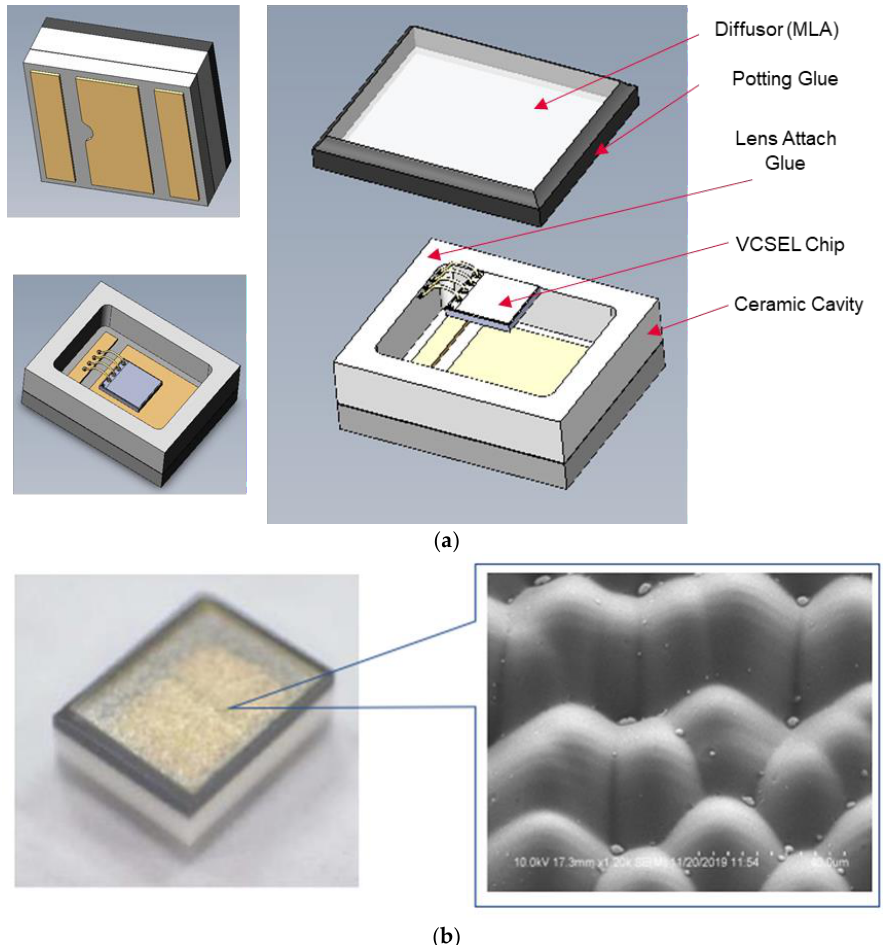
Figure 1. The VCSEL package. ( a ) component structure for package; ( b ) the actual package with diffuser and SEM image for microstructure on top lens.